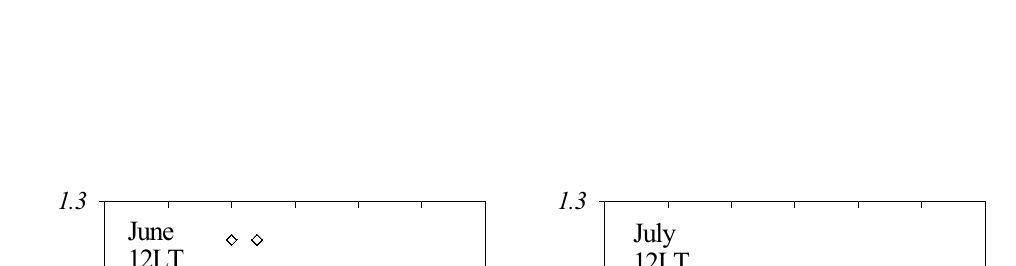
Figure 2. June monthly median foF 2 diurnal variations at ionospheric stations located in the anomaly area (Yakutsk, Magadan) and outside this area (Tunguska, St. Petersburg) under solar maximum (1970, 1981) and solar minimum (1975,1986) conditions.